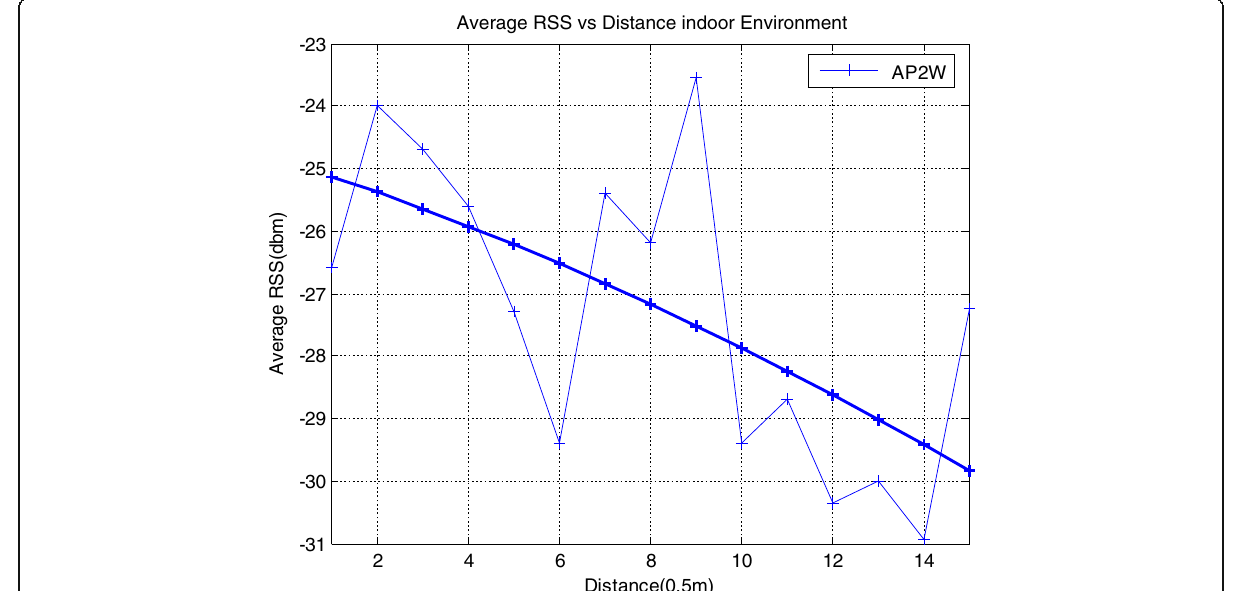
Fig. 7 The left corridor RSS signal changes (middle). In the left corridor, AP 2 RSS ’ s change